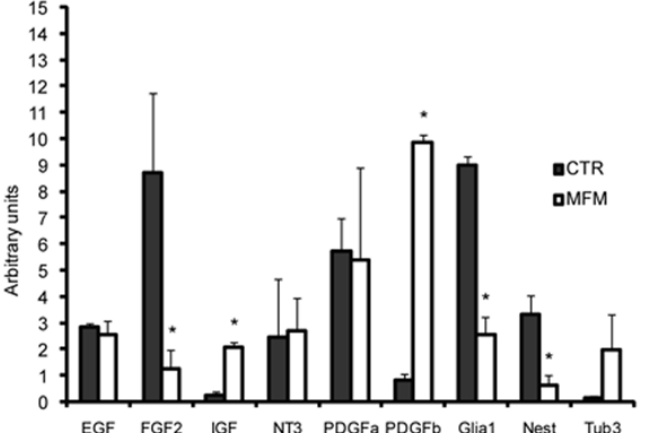
Fig. 4 – Immunolabeling of neurospheres slices for neurons ( β -tubulin III – in red) and astrocytes (GFAP – in green) from the CTR and E/F-less groups of mNPC. GFAP positive cells were found across the whole neurosphere, whereas β -tubulin III positive cells were concentrated in the neurosphere core. A fusion of two neurospheres is shown for the (E/F-less) group. Despite the fusion, neurons are localized at the borders of the neurospheres. Total nuclei were stained with DAPI (blue). 200X magnification.